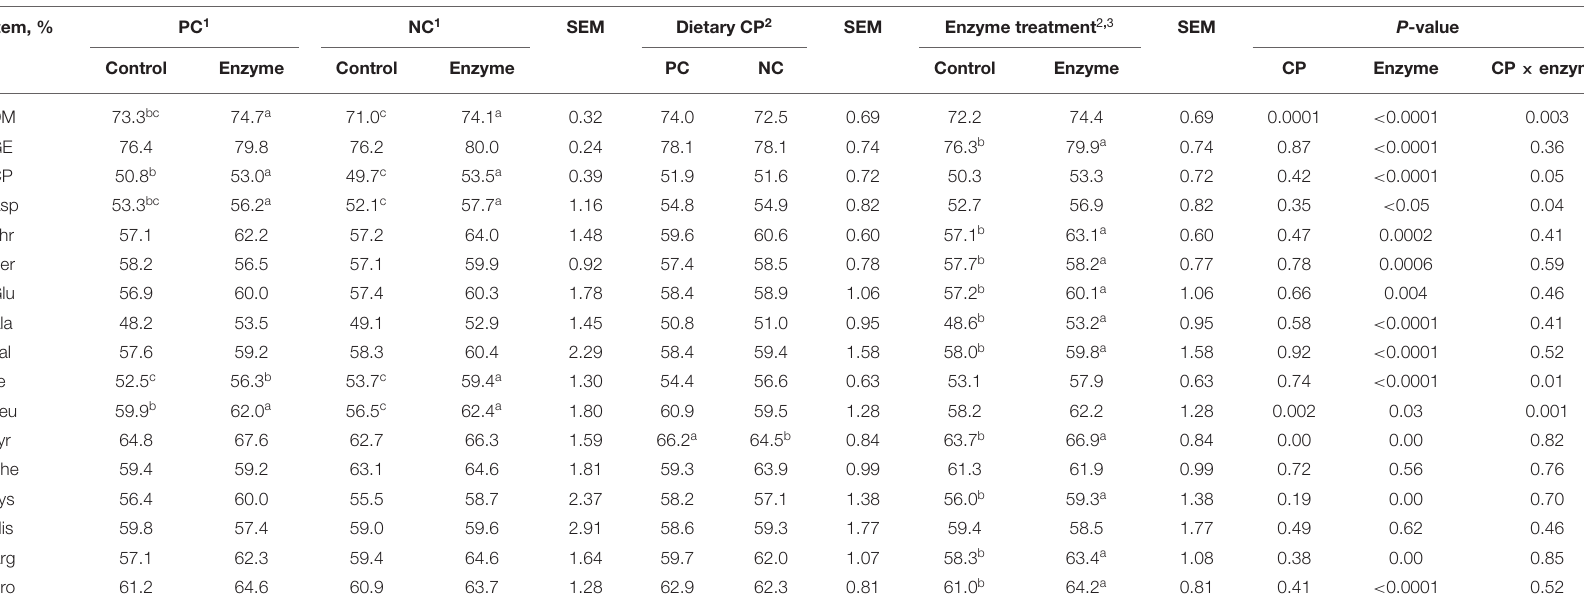
TABLE 6 | Effects of NSP enzymes and protease on digestibility of DM, GE, CP, and amino acids of yellow-feathered broilers fed with diets with different CP levels. Item,